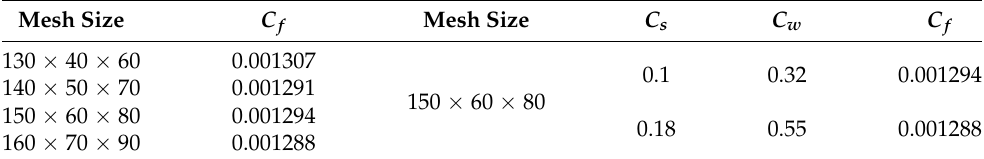
Figure 3. Mean streamwise velocity normalized with u τ . The dashed yellow line is the theoretical prediction u + = y + in the viscous sublayer. The dashed blue line is the fit u + = 2.44ln log-layer region. Table 2. Grid and Wale constant independence validation. C f is drag coefficient on the bottom wall, C s is Smagorinsky constant, C w is Wale constant.